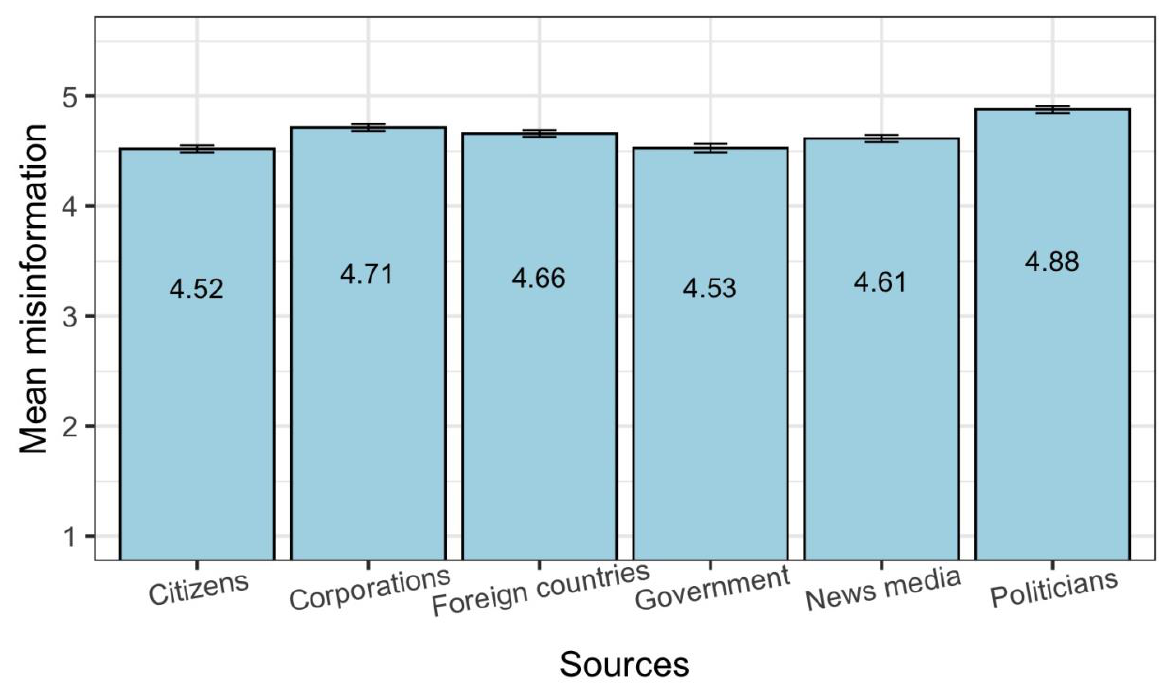
Figure 1. Mean misinformation perceptions for different sources. All perceptions are measured on 7-point scales (1= source never spreads misinformation, 7 = source spreads misinformation all the